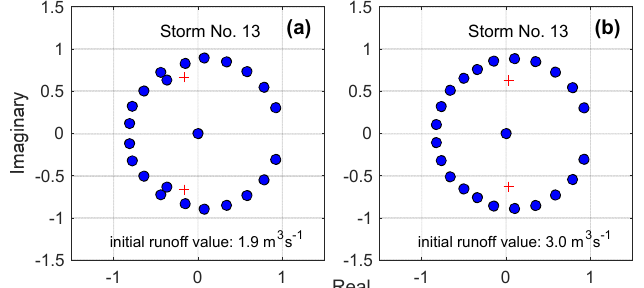
Figure 7. Comparison between Argand diagrams for Storm No. 13 of Nenagh basin obtained by altering initial runoff value: ( a ) for initial runoff of 1.9 m 3 s − 1 (original), ( b ) for initial runoff of 3.0 m 3 s − 1 (altered).